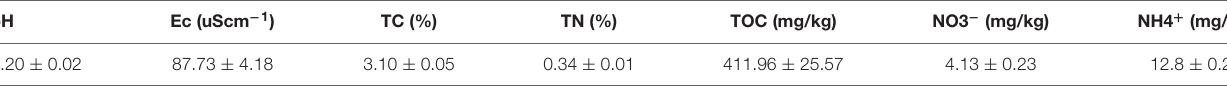
TABLE 1 | The physical and chemical characterization of